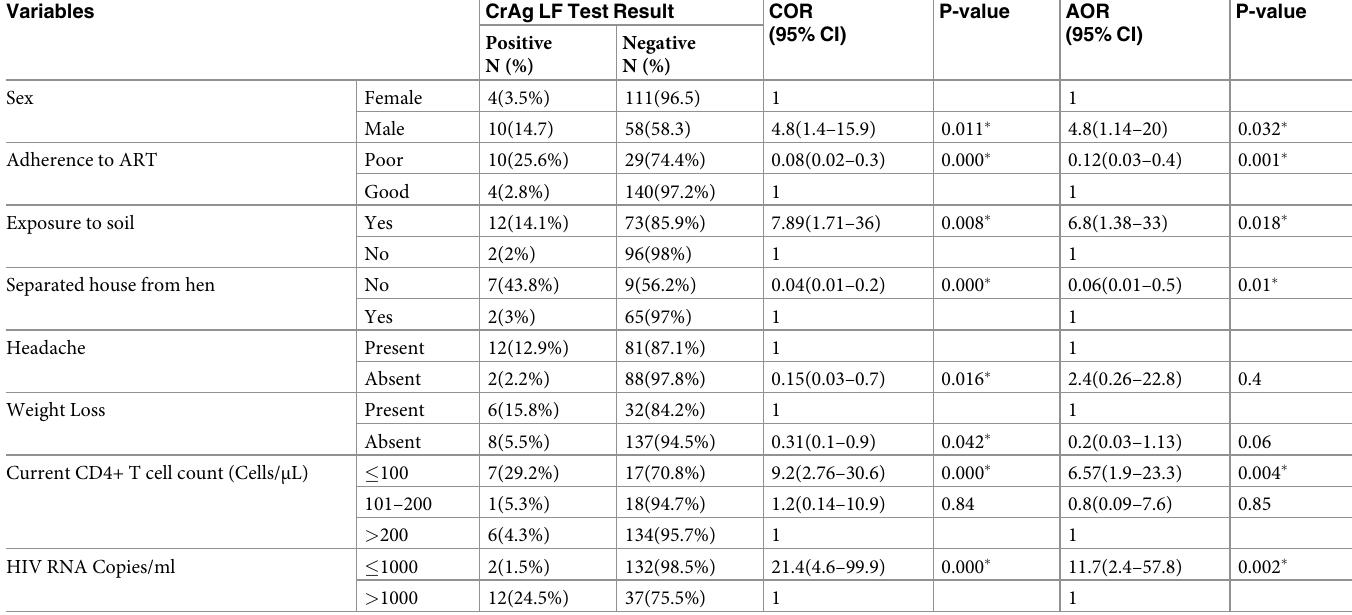
Table 4. Assessment of risk factors associated with CrAg among HIV patients on second line ART at two hospitals, Western Oromia, Ethiopia from September 1, 2017, to November 30,